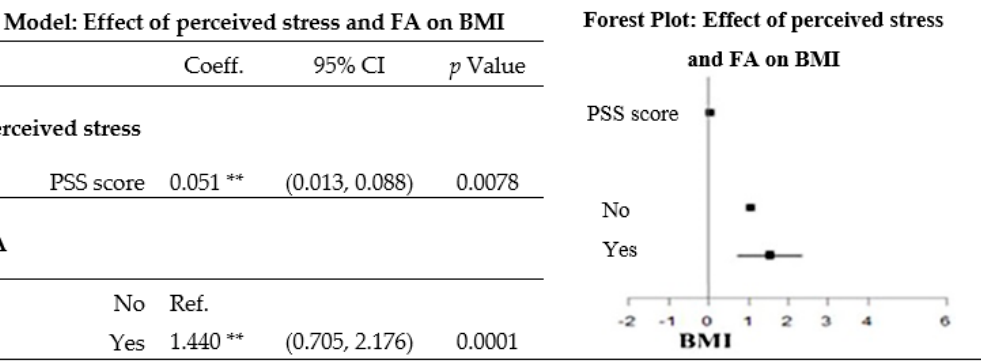
Figure 3. Effect of perceived stress and food addiction (FA) on the body mass index (BMI) after adjusting for sociodemographic variables. The model was obtained from a multiple linear regression, and was adjusted for sex, age group, employment status, and educational attainment. ** 0.0001 ≤ p - value ≤ 0.01. PSS, Perceived Stress Scale; Coeff., coefficient; Ref., reference.